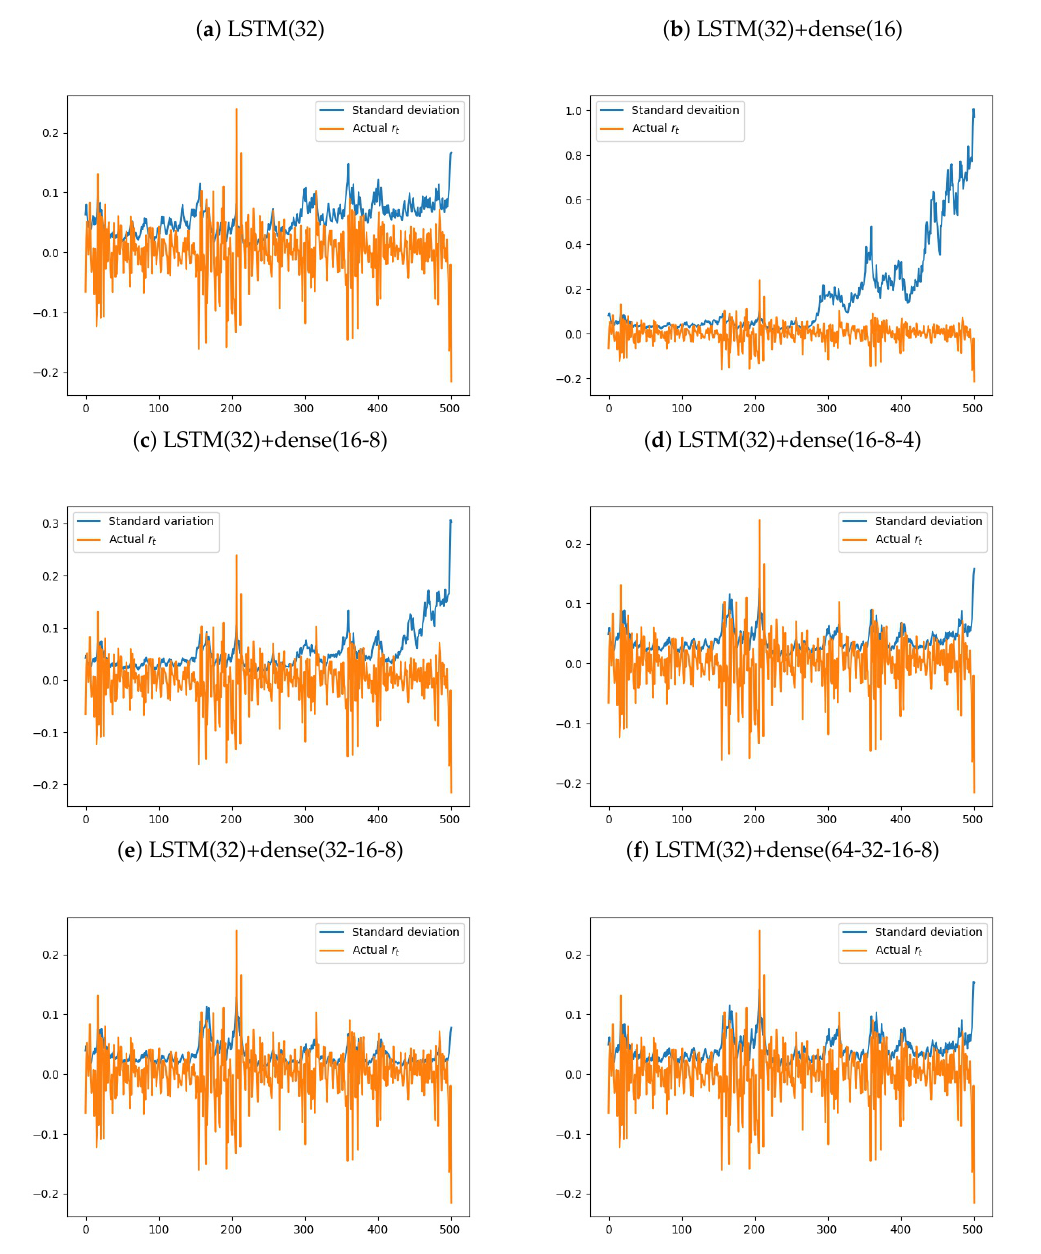
Figure 5. Actual r t and the predicted standard deviation. To visualize the model performances, we plotted actual r t and the predicted standard deviation in the same graphs. Except for LSTM(32)+dense(32), when actual r t fluctuates more rapidly, the predicted standard deviation